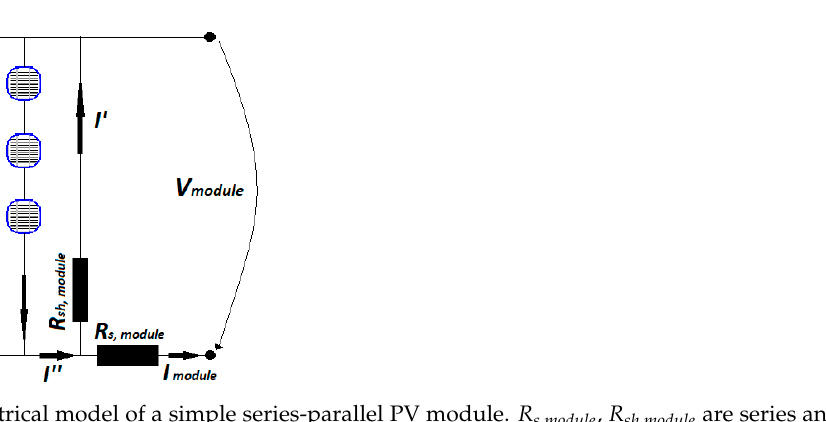
Figure 3. Electrical model of a simple series-parallel PV module. R s,module , R sh,module are series and shunt resistance, respectively.